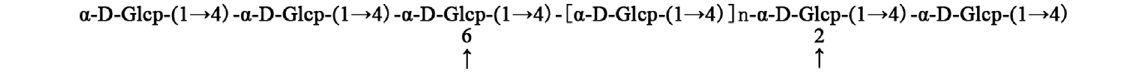
FIGURE 6 | Possible repeating unit of APOS.